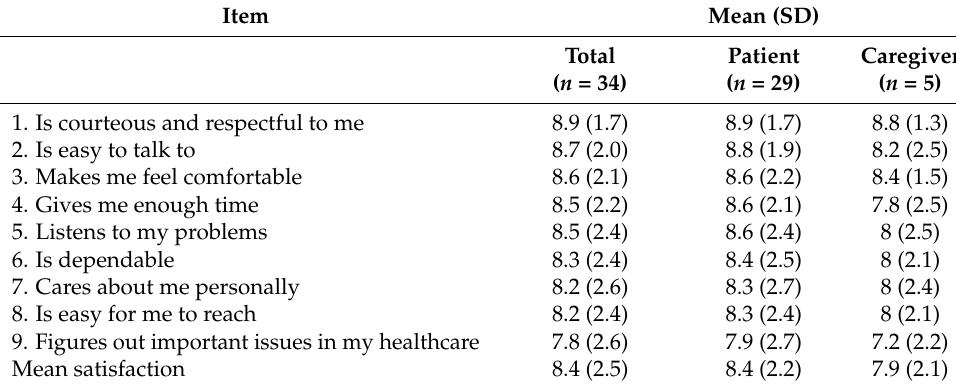
Table 2. Satisfaction with interpersonal relationship with navigator